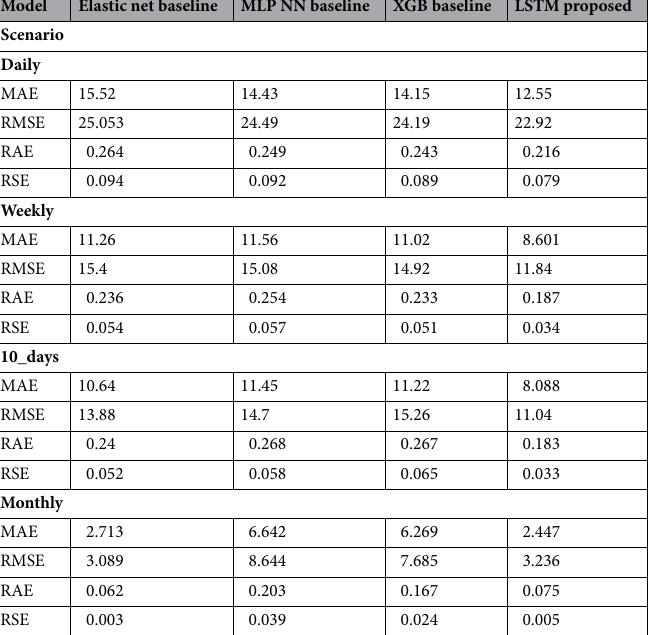
Table 2. Performance indicators for four scenarios: daily, weekly, 10-days, monthly, and four models: Elastic Net, MLP, XGB, and LSTM.